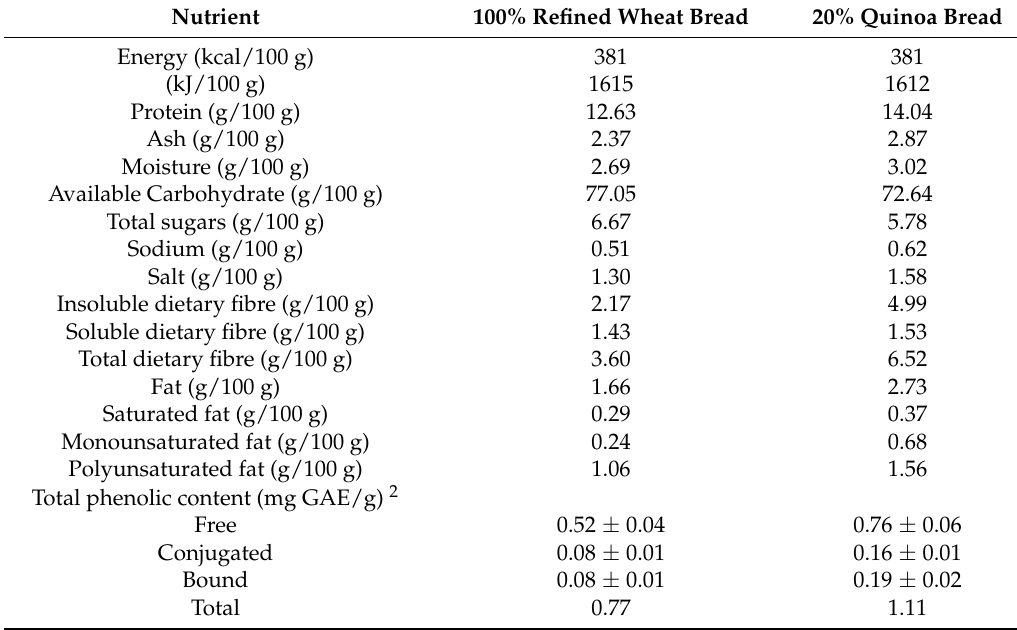
Table 1. Proximate composition of refined wheat and quinoa bred (dry basis) 1